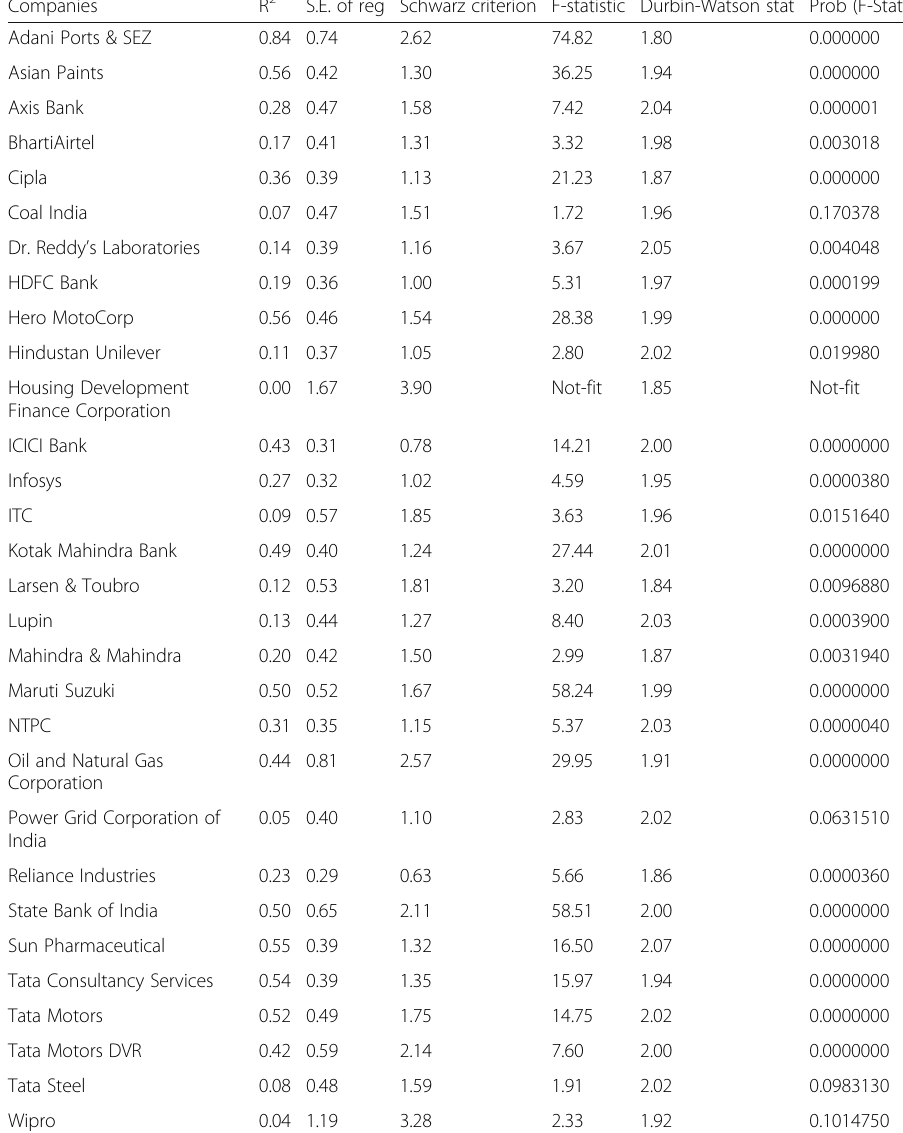
Table 6 Summary results of Auto ARIMA Companies R 2 S.E. of reg Schwarz criterion F-statistic Durbin-Watson stat Prob